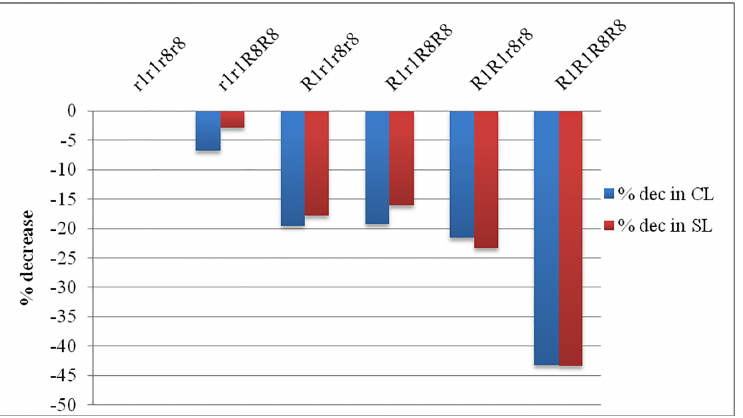
Fig 3. Percent decrease in CL and SL in each genotypic